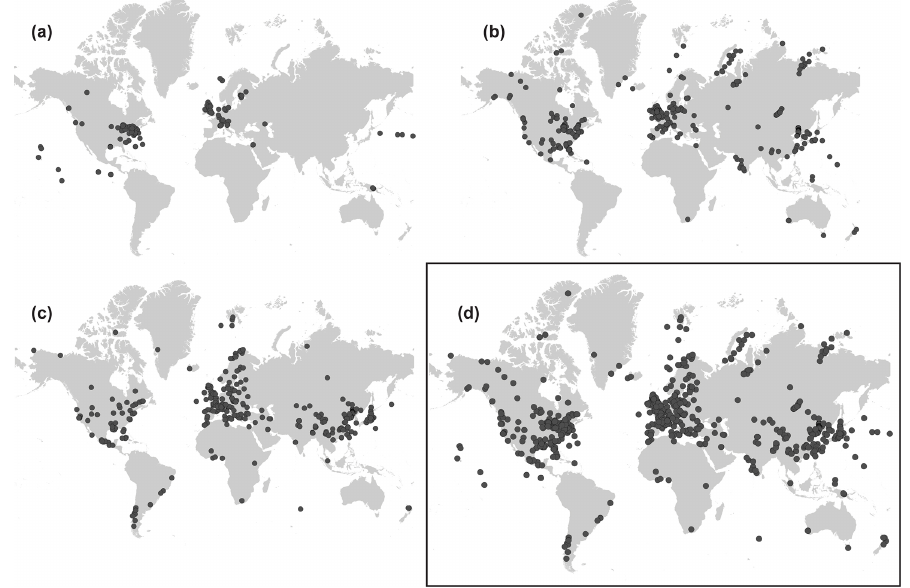
Figure 1. Location of the sediment cores included in the database. (a) Sediment cores described in articles published between 1977 and 1990, (b) between 1990 and 2005, and (c) between 2005 and 2020. (d) Full database of sediment cores compiled in the current research.